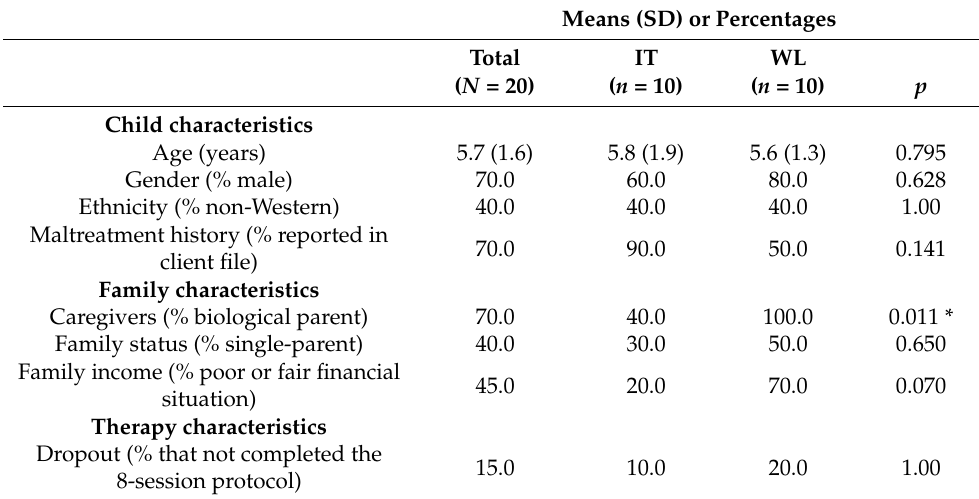
Table 1. Demographic information for the total sample and by randomization